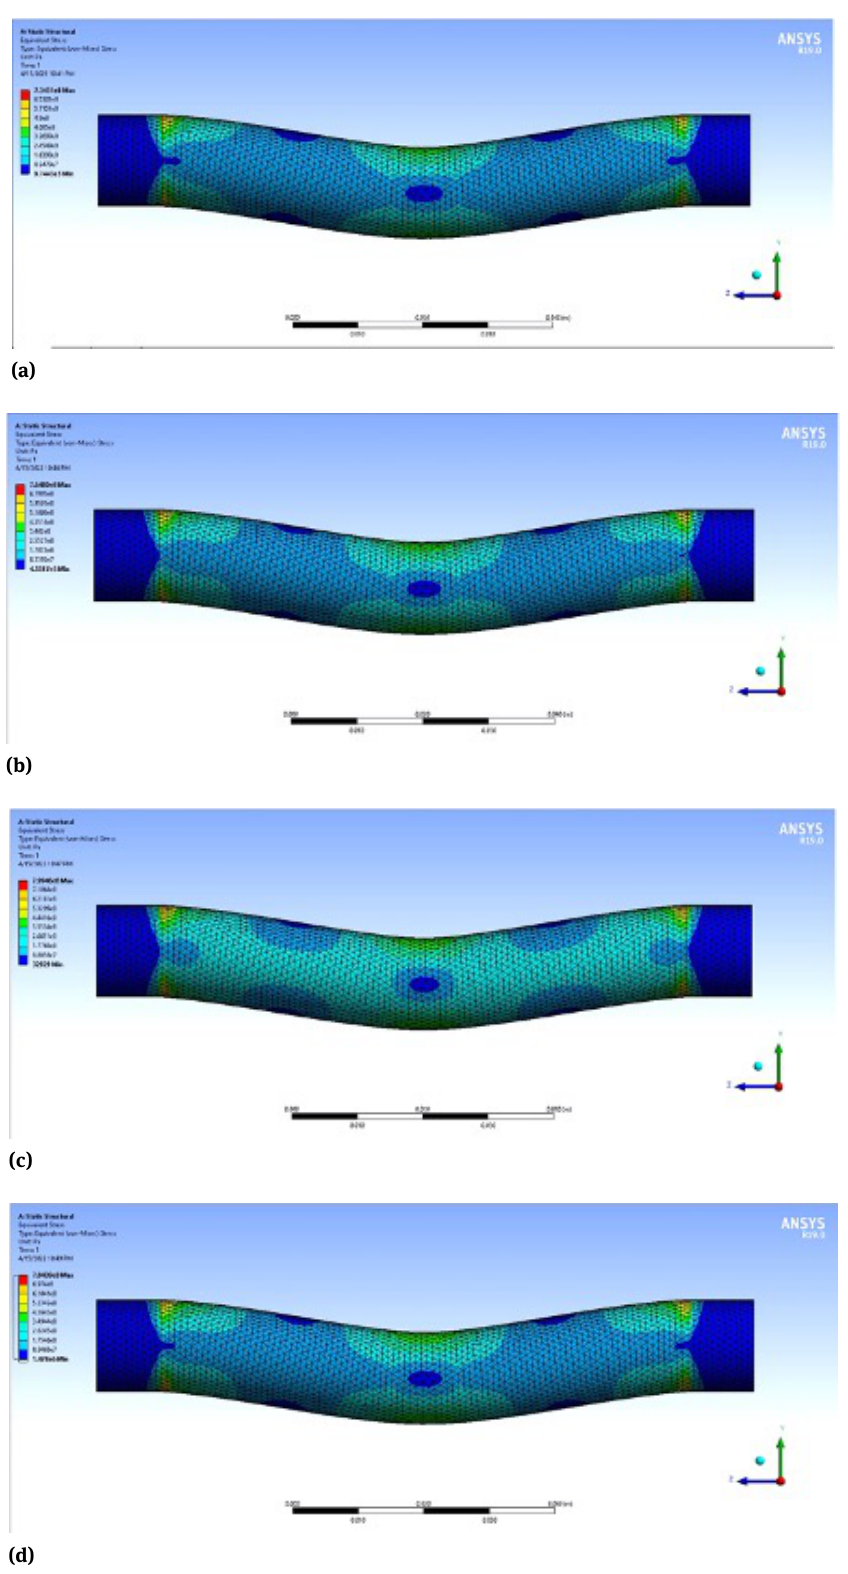
Figure 9: Stirs contour. (a) 0 0 0, (b) 0 0 45, (c) 0 0 90, (d) 0 45 0, (e) 0 45 90, (f) 0 90 0, (g) 45 0 0, (h) 45 45 45, (i) 90 0 0, (j) 90 45 0, (k)